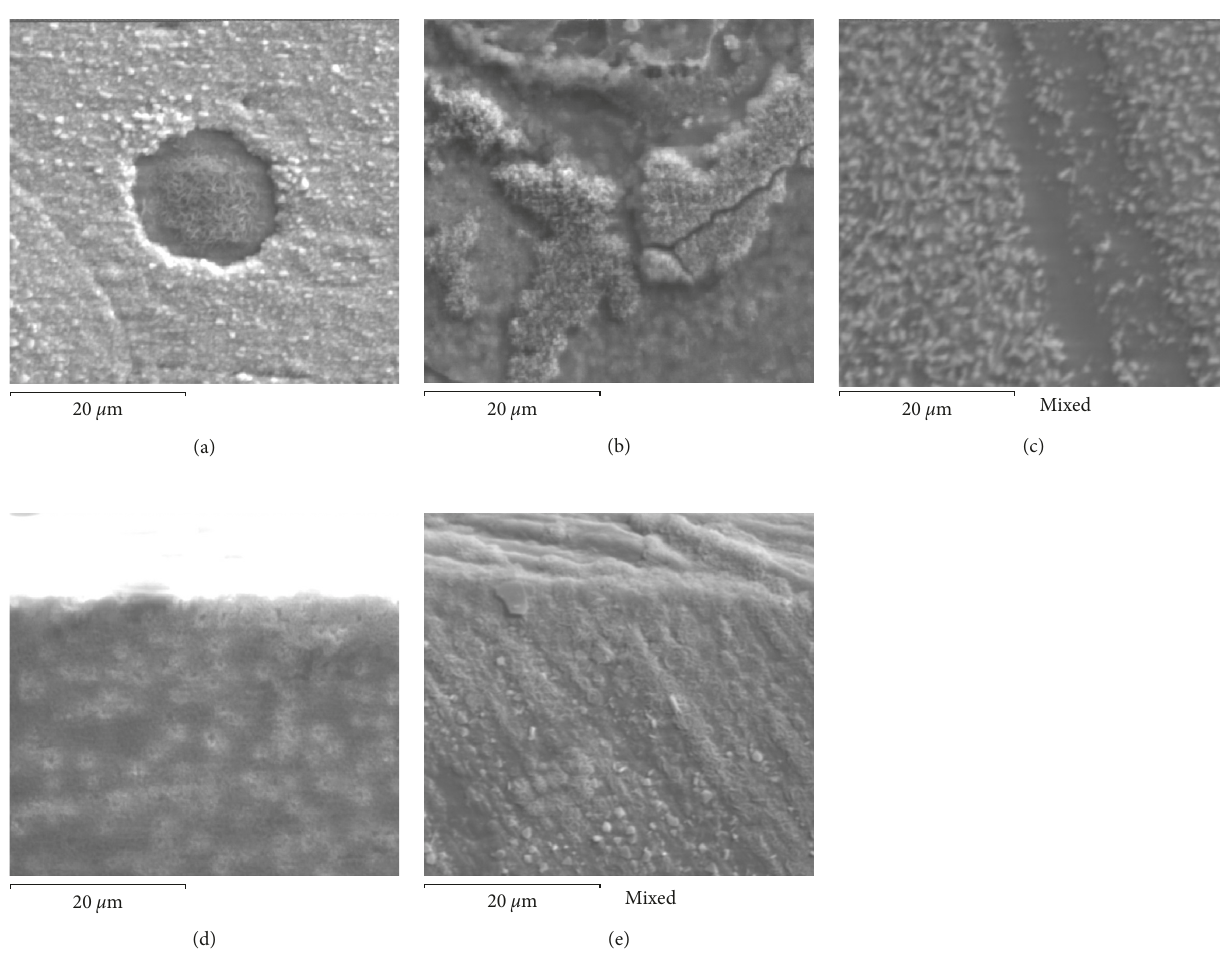
Figure 11: SEM micrographs showing the surface morphology of the oxide scales at 900 ° C: (a) Ni Au, (d) Ni 3 Al +1.0% Pd, and (e) Ni 3 Al+1.0%